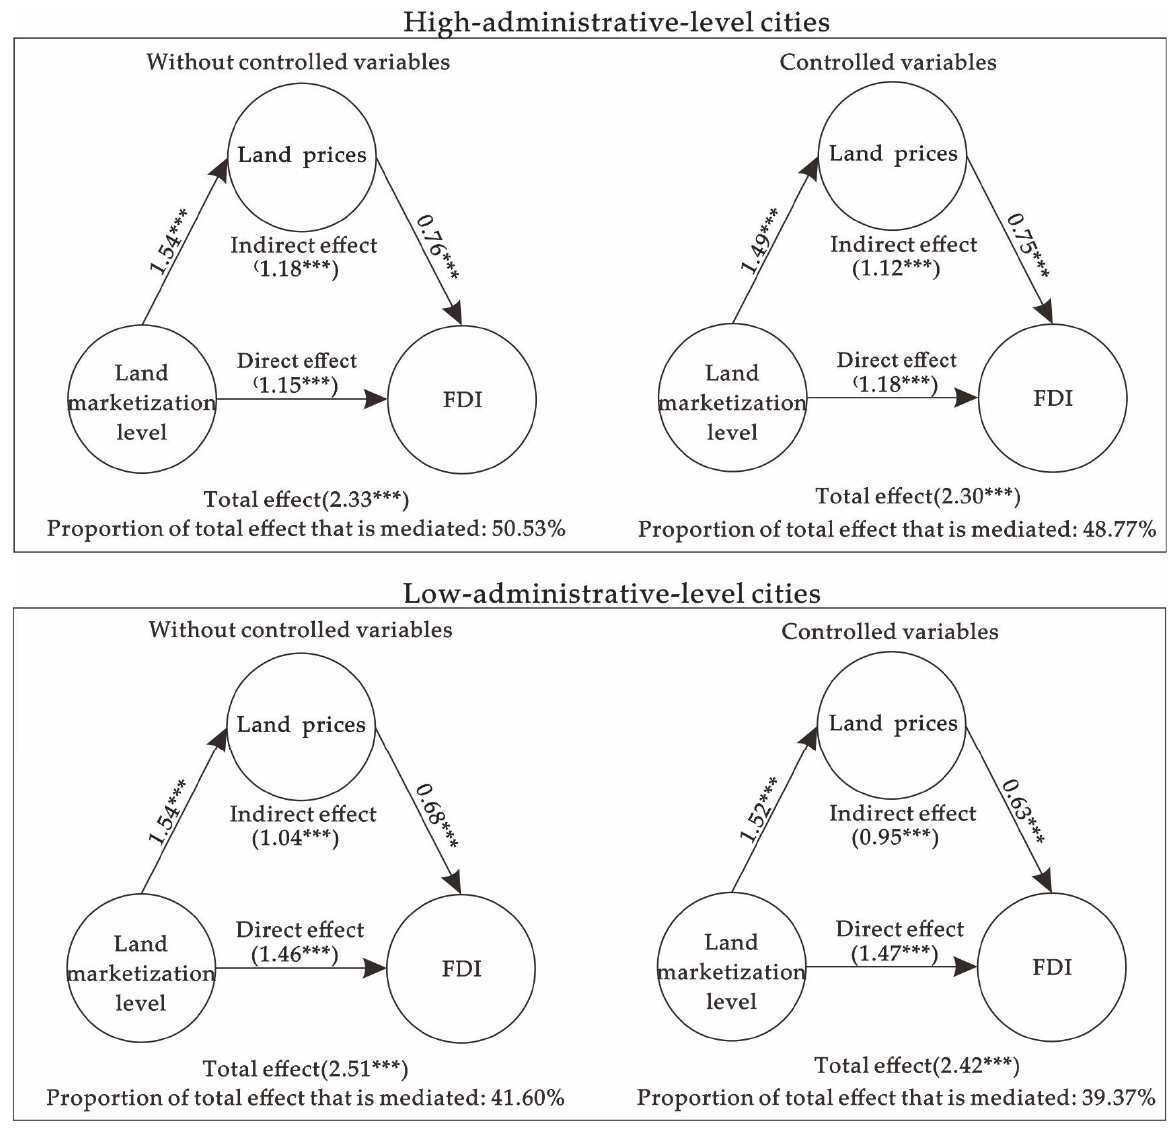
Figure 8. Effects of land marketization level and land prices on FDI in cities of different administra ‐ tive levels. Note: *** p < 0.01.